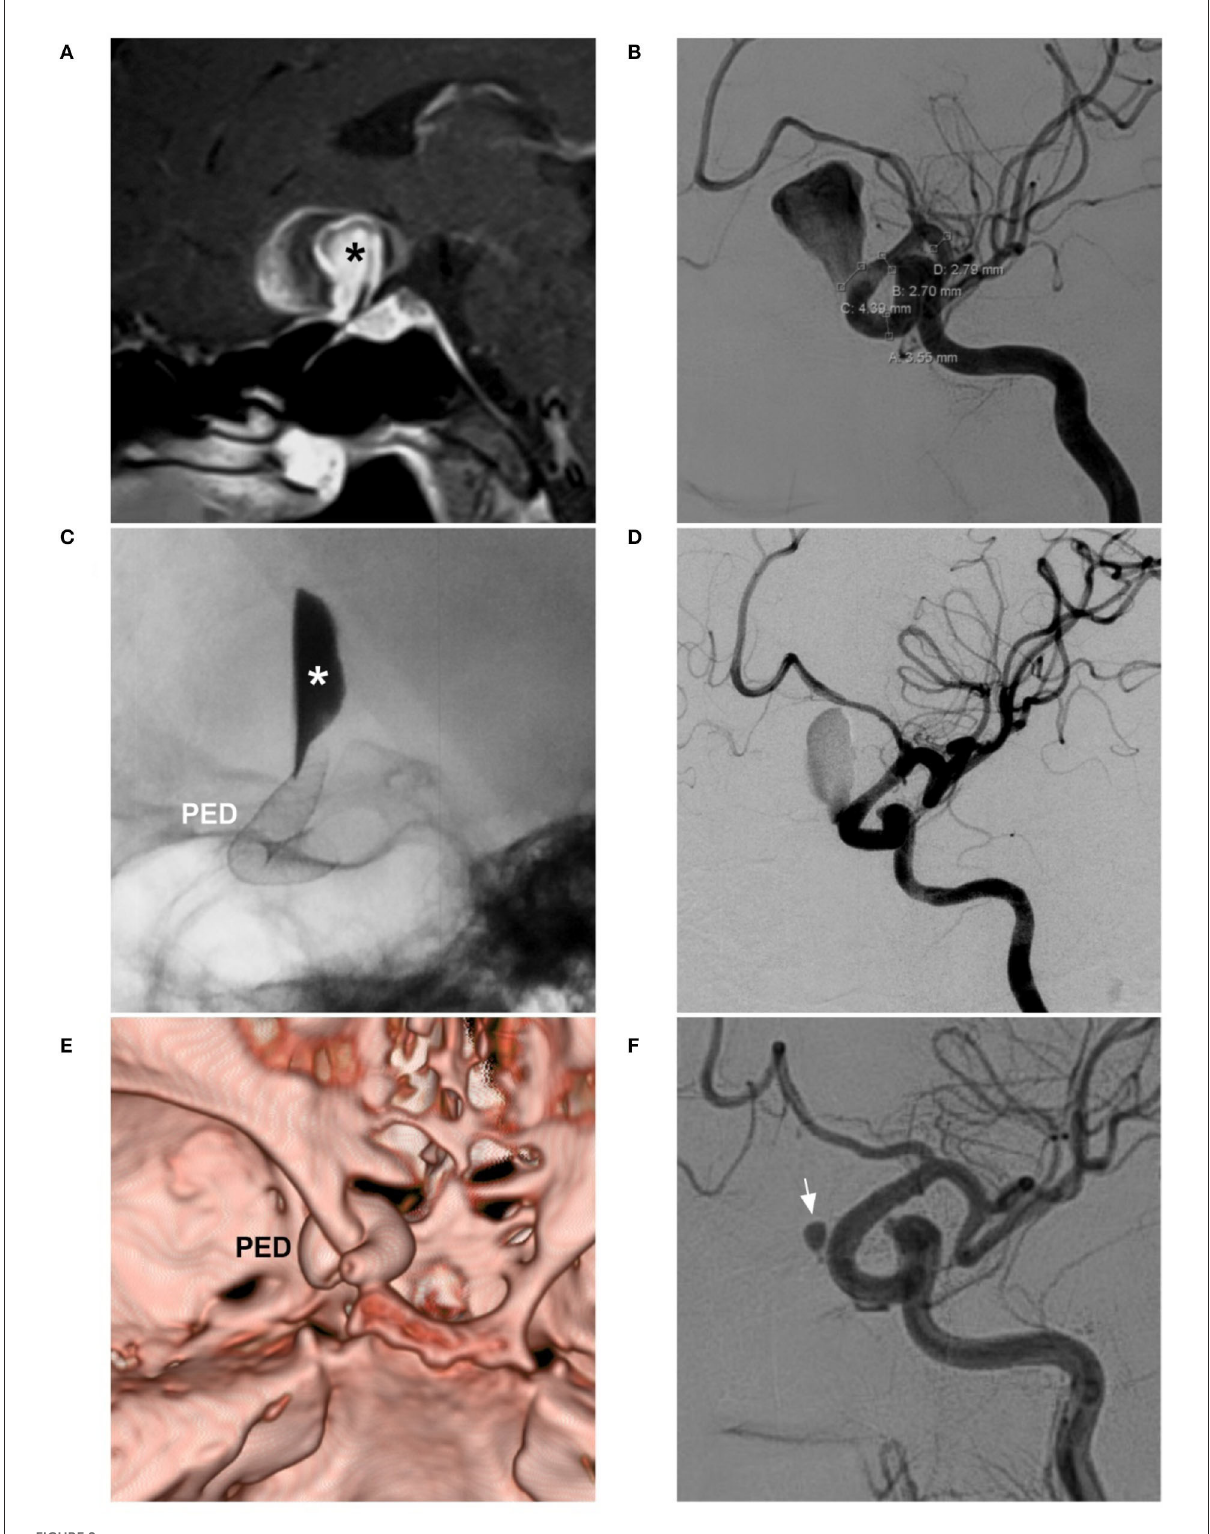
FIGURE8 FDS deployment in a giant aneurysm without coiling. (A) Sagittal MRI shows a giant aneurysm with jet flow in the middle (asterisk). (B) DSA shows the aneurysm sac. (C) X-ray shows that contrast agent retention (asterisk) can be seen after FDS (PED) deployment. (D) Postoperative DSA shows reduced blood flow into the aneurysm. (E) Postoperative 1-week CTA shows the location of the PED. (F) Follow-up DSA at 6 months